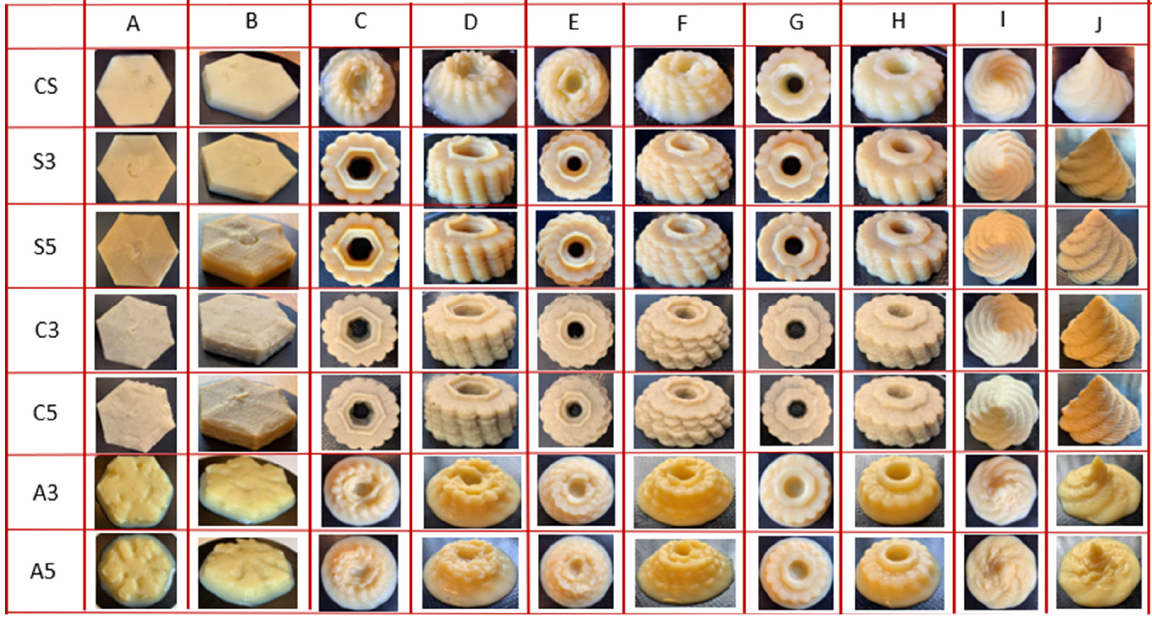
Figure 4. Pictures of 3D printing formulations with different proteins. Note: CS (Control Sample), S3 (3% Soy), S5 (5% Soy), C3 (3% Cricket), C5 (5% Cricket), A3 (3% Albumin), and A5 (5% Albumin). ( A ) 8 layers hexagon shape top ( B ) 8 layers hexagon shape side ( C ) 13 layers flower shape top ( D ) 13 layers flower shape side ( E ) 11 layers flower shape top ( F ) 11 layers flower shape side ( G ) 9 layers flower shape top ( H ) 9 layers flower shape side ( I ) 28 layers mountain shape top ( J ) 28 layers